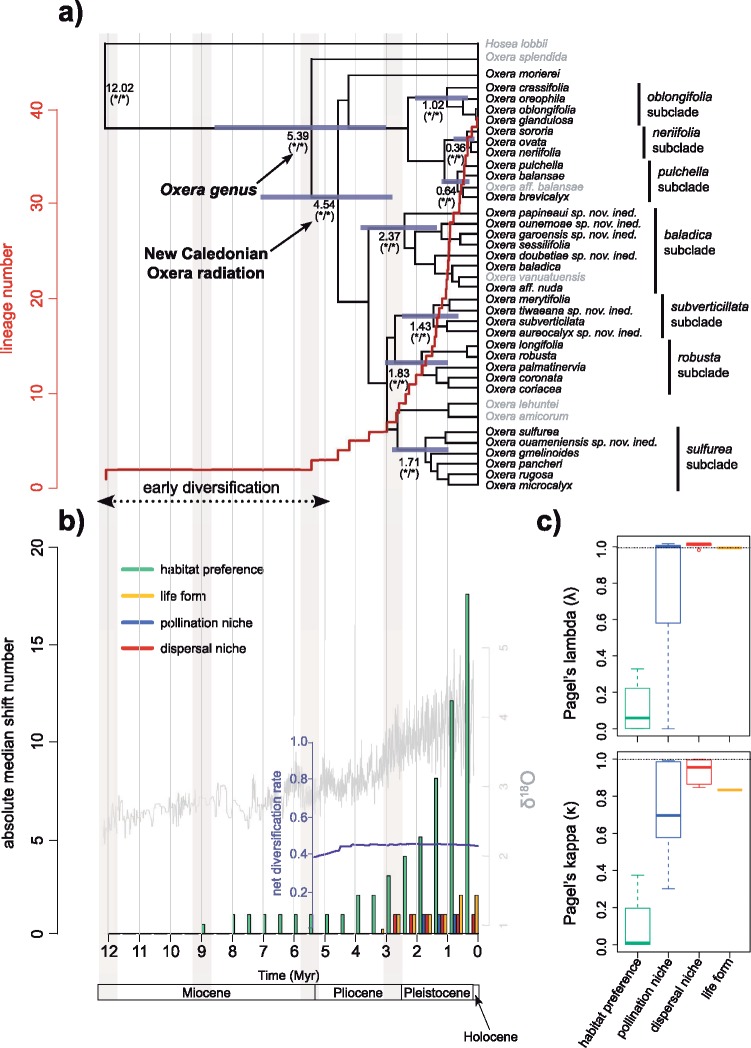
Evolutionary history of Oxera in New Caledonia, and of its habitat preferences, pollination and dispersal niches, and life forms. a) BEAST chronogram of the Oxera data set with superimposed lineage through time plot. Median age estimates and blue node bars (corresponding to the 95% highest posterior densities) are indicated for each node of interest. Bayesian PP from the BEAST analyses (on the right) and MCMC Bayesian analyses (on the left) are indicated with an asterisk for each node of interest when \documentclass[12pt]{minimal}
\usepackage{amsmath}
\usepackage{wasysym} 
\usepackage{amsfonts} 
\usepackage{amssymb} 
\usepackage{amsbsy}
\usepackage{upgreek}
\usepackage{mathrsfs}
\setlength{\oddsidemargin}{-69pt}
\begin{document}
}{}$>$\end{document}0.95, and with a hyphen when \documentclass[12pt]{minimal}
\usepackage{amsmath}
\usepackage{wasysym} 
\usepackage{amsfonts} 
\usepackage{amssymb} 
\usepackage{amsbsy}
\usepackage{upgreek}
\usepackage{mathrsfs}
\setlength{\oddsidemargin}{-69pt}
\begin{document}
}{}$<$\end{document}0.95. Vertical light grey rectangles indicate periods of intense weathering as inferred from Chevillotte et al. (2006). b) Absolute shift timings of the three niches and life forms inferred from stochastic character mappings, with global delta \documentclass[12pt]{minimal}
\usepackage{amsmath}
\usepackage{wasysym} 
\usepackage{amsfonts} 
\usepackage{amssymb} 
\usepackage{amsbsy}
\usepackage{upgreek}
\usepackage{mathrsfs}
\setlength{\oddsidemargin}{-69pt}
\begin{document}
}{}$^{18}$\end{document}O variation through time (in grey; from Zachos et al. 2001) and net diversification rate variation through time of Oxera, as inferred from BAMM analyses (in dark blue), superimposed. c) Phylogenetic signal for habitat preferences, pollination and dispersal niches, and life forms inferred from estimations of the \documentclass[12pt]{minimal}
\usepackage{amsmath}
\usepackage{wasysym} 
\usepackage{amsfonts} 
\usepackage{amssymb} 
\usepackage{amsbsy}
\usepackage{upgreek}
\usepackage{mathrsfs}
\setlength{\oddsidemargin}{-69pt}
\begin{document}
}{}$\kappa$\end{document} and \documentclass[12pt]{minimal}
\usepackage{amsmath}
\usepackage{wasysym} 
\usepackage{amsfonts} 
\usepackage{amssymb} 
\usepackage{amsbsy}
\usepackage{upgreek}
\usepackage{mathrsfs}
\setlength{\oddsidemargin}{-69pt}
\begin{document}
}{}$\lambda$\end{document} Pagel statistics.